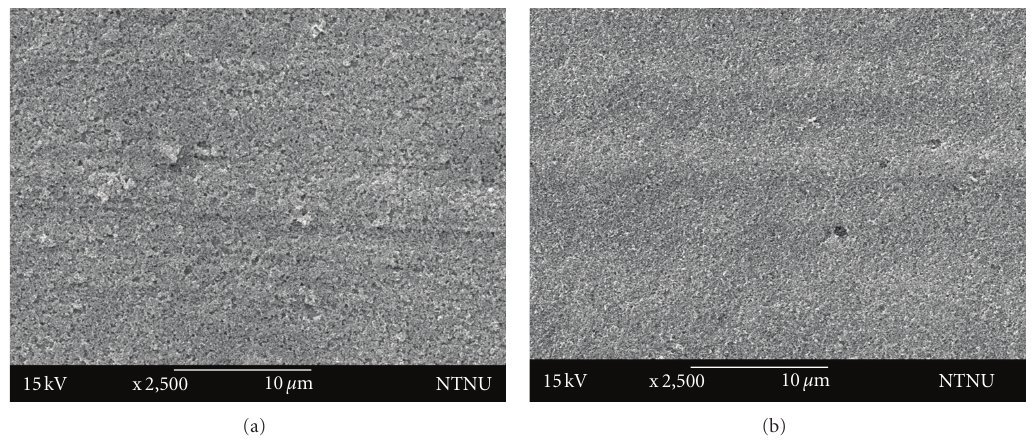
Figure 8: SEM photograph of the TiO 2 -deposited film at the optimal parameter of EPD, (a) side A, (b) side B.